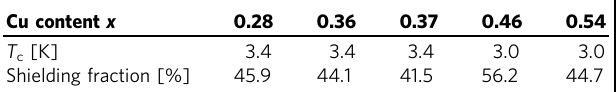
Table 1 The T c and the shielding fraction at T = 1.8 K for the fi ve Cu contents discussed in this paper.